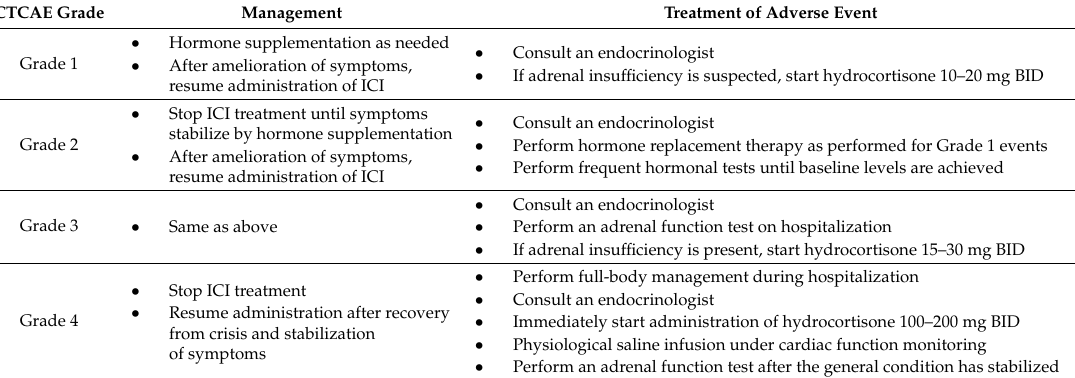
Table 3. Management of adrenal insu ffi ciency induced by immune checkpoint